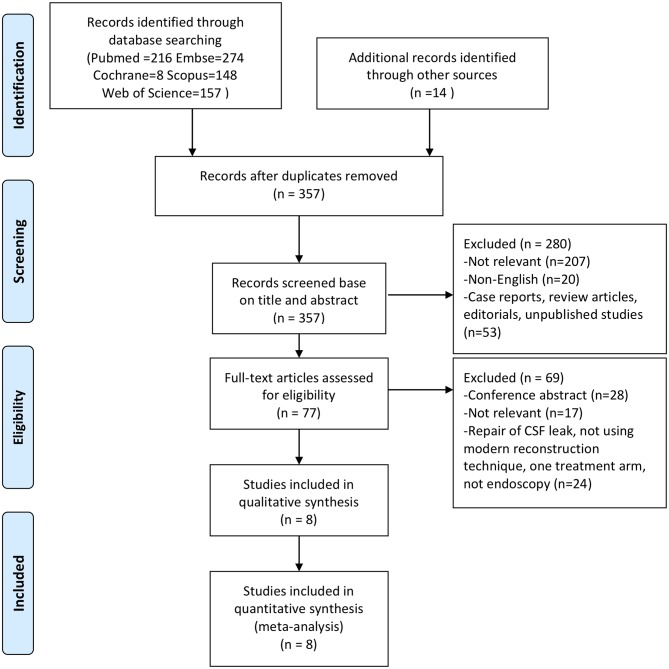
Preferred Reporting Items for Systematic Reviews and Meta-Analyses (PRISMA) flowchart summarizing the screening and selection process.